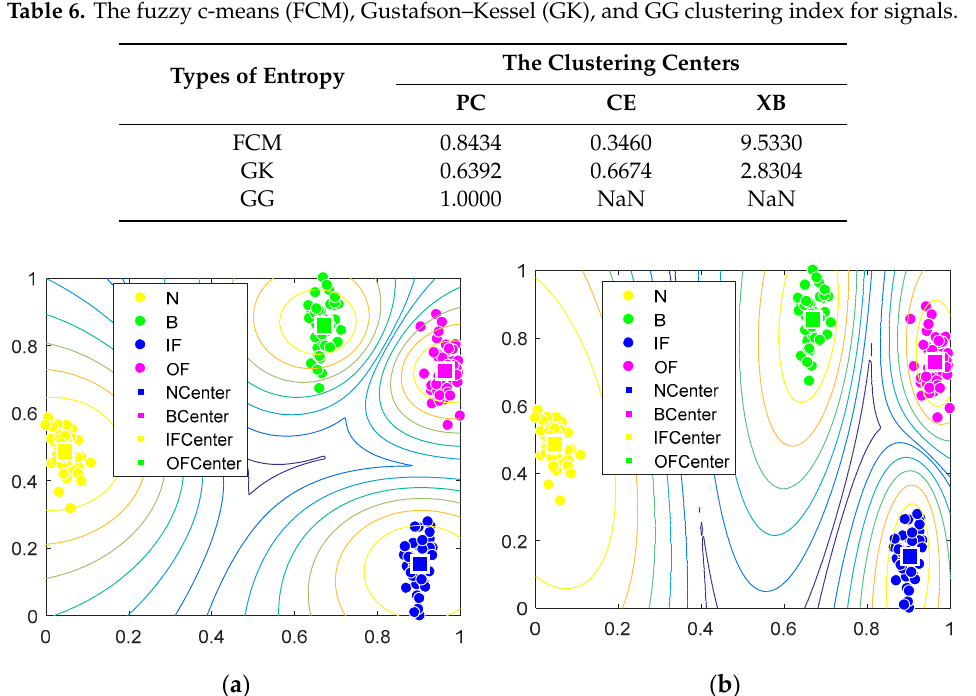
Figure 9. ( a ) The FCM clustering contour for PE. ( b ) The GK clustering contour for PE.